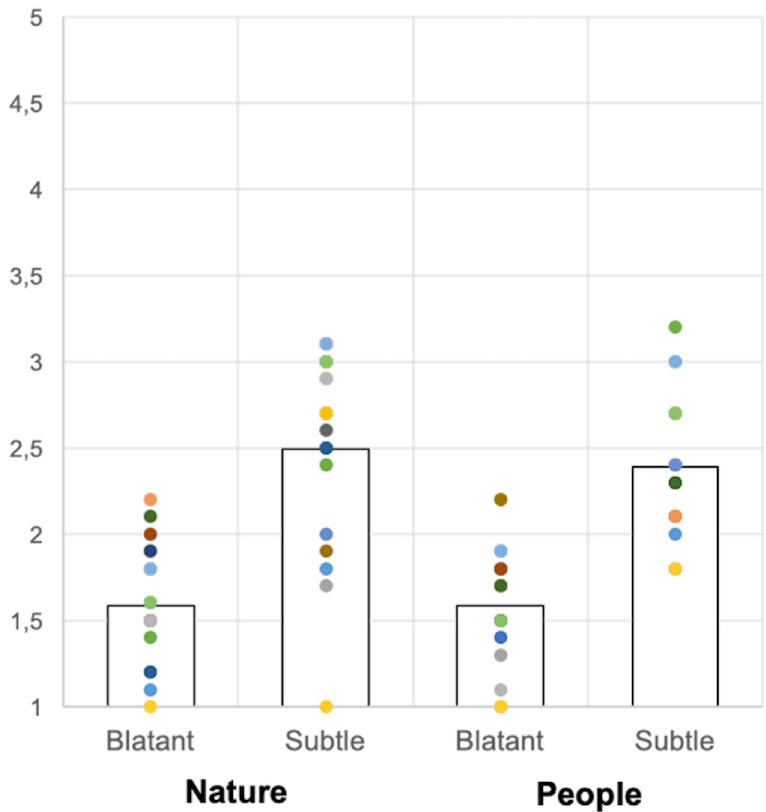
Fig 2. Subtle and Blatant Prejudice Scale. Scores obtained on the Subtle and Blatant Prejudice Scale by the two experimental groups. Scores could range from 1 (minimum prejudice) to 5 (maximum prejudice); for both groups, explicit prejudice (blatant) was significantly lower than the implicit one